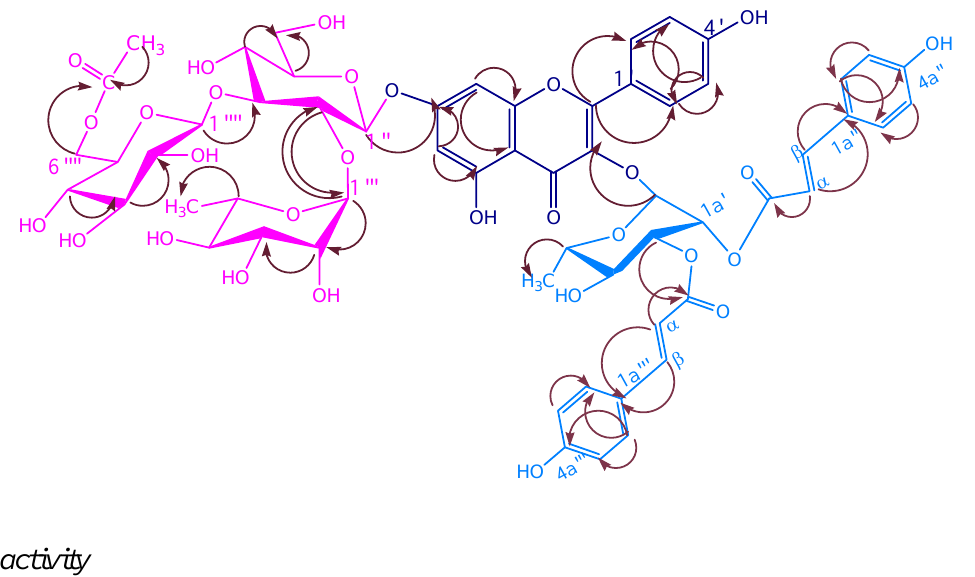
Figure 6 : Significant HMBC correlations for KSR4 . Arrows point from H to